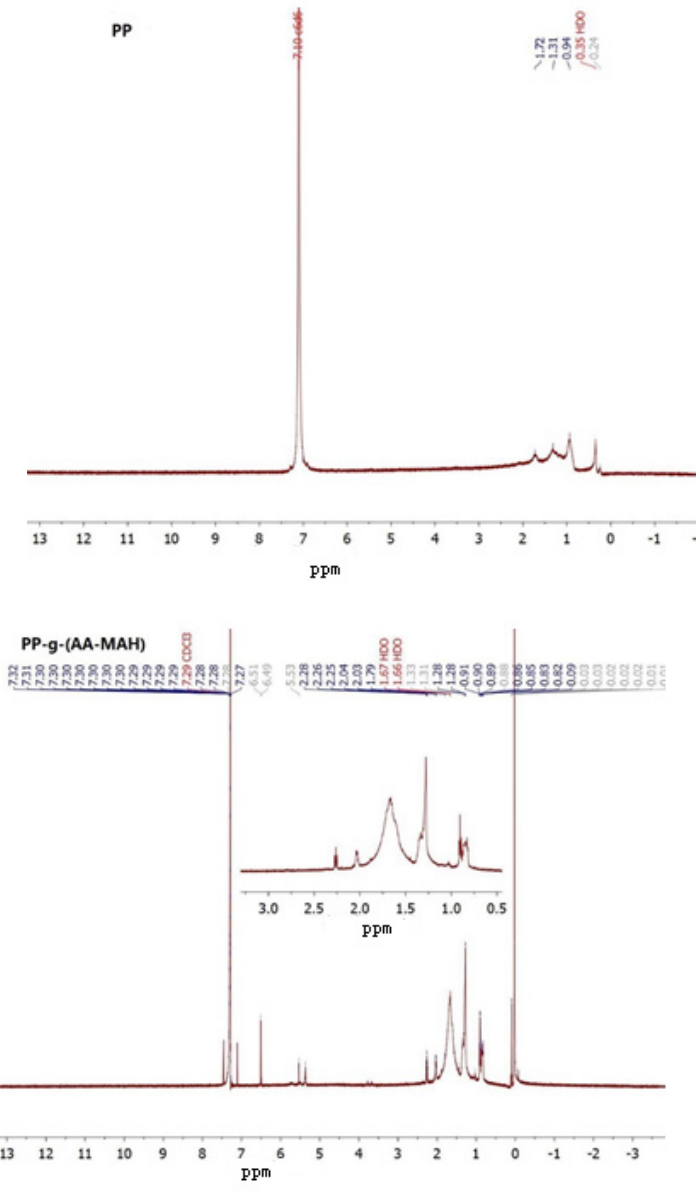
Figure 8. 1 H-NMR analysis of PP and PP-g-(AA-MAH) fibers.